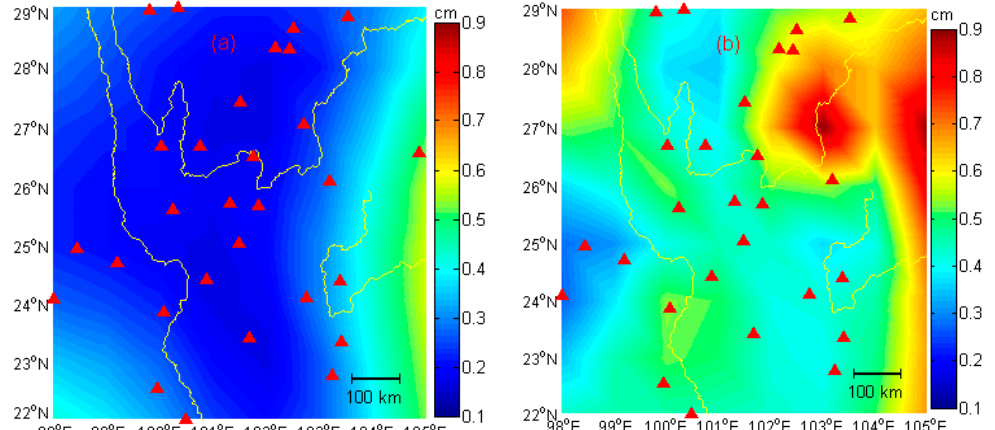
Figure 7. Uncertainties of the two solutions. ( a ) Uncertainties of HVCE method; ( b ) Uncertainties of the MMSE method. The uncertainties are derived by performing a boot-strapping approach.